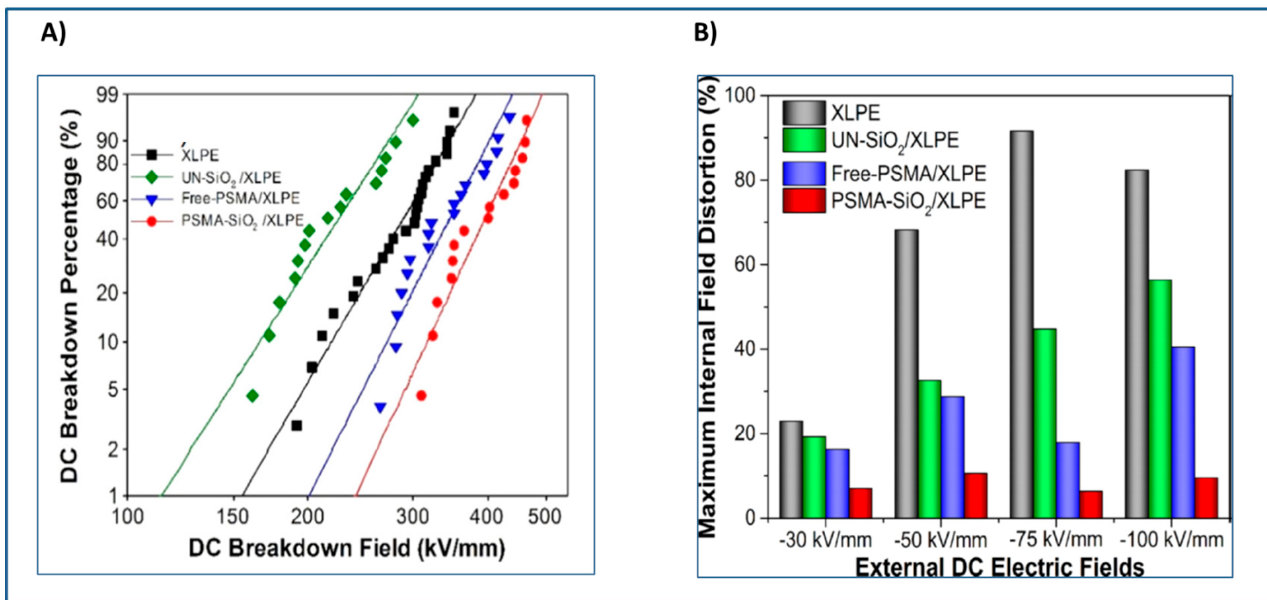
Figure 11. ( A ) Weibull distribution of DC breakdown strength, ( B ) Maximum internal field distortion under external DC electric fields. Reproduced with permission from Ref. [177].